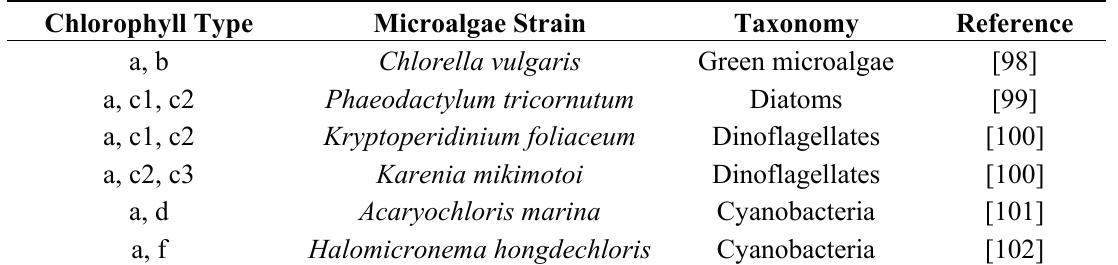
Table 2. Types of chlorophyll present in eukaryotic microalgae and